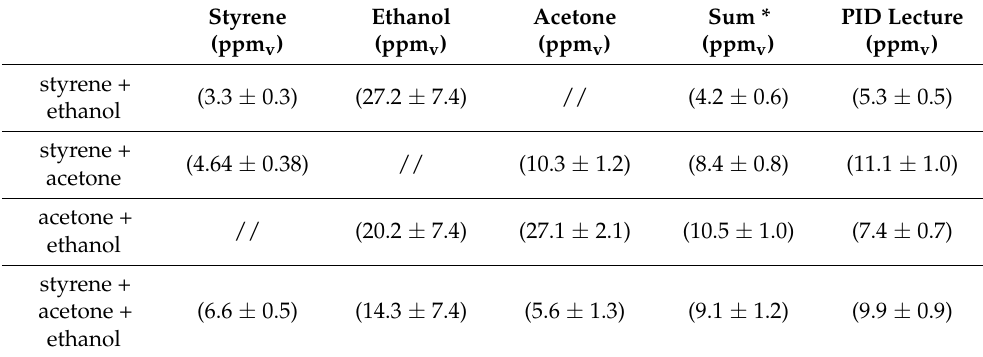
Table 2. Concentration values (ppm v ) extrapolated from the integrated areas of the absorbance peaks for different mixtures. The sum of the calculated values can be compared with the PID